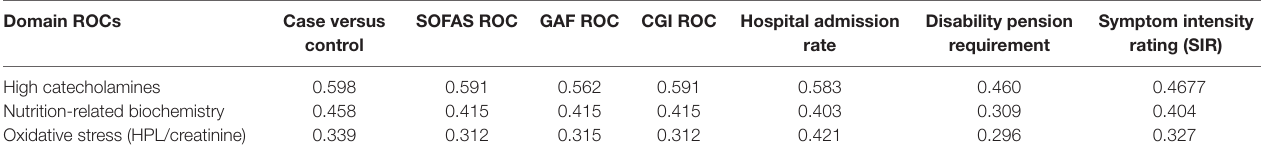
TaBle 1 | nutritional biochemistry domain, elevated catecholamine and oxidative stress domain rOcs, with respect to functional measures of disability and severity. Domain